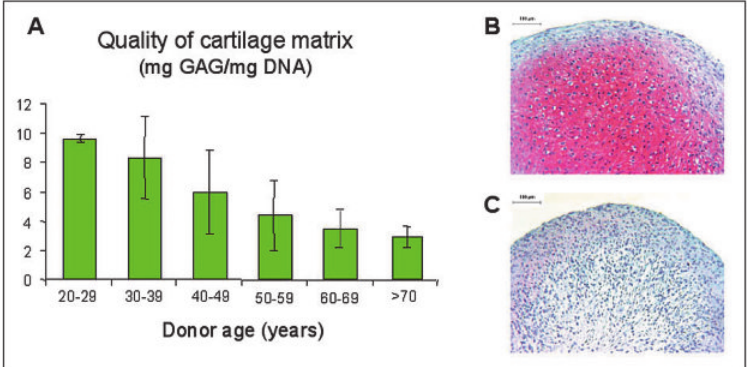
Variability of engineered cartilage quality using articular chondrocytes from different donors. Quality of the cartilage tissues engineered by expanded chondrocytes, here quantified using the content of glycosaminoglycans (GAG)/DNA following pellet cul- ture, depends on the age of the donor but is additionally highly variable between cells from donors in the same age range (see large standard deviations in A). Differences in matrix quality are demonstrated by safranin-O staining for GAG of generated cartilage from cells of a donor with good (B) or bad (C) re-differentiation capacity, within the same age range (40–49